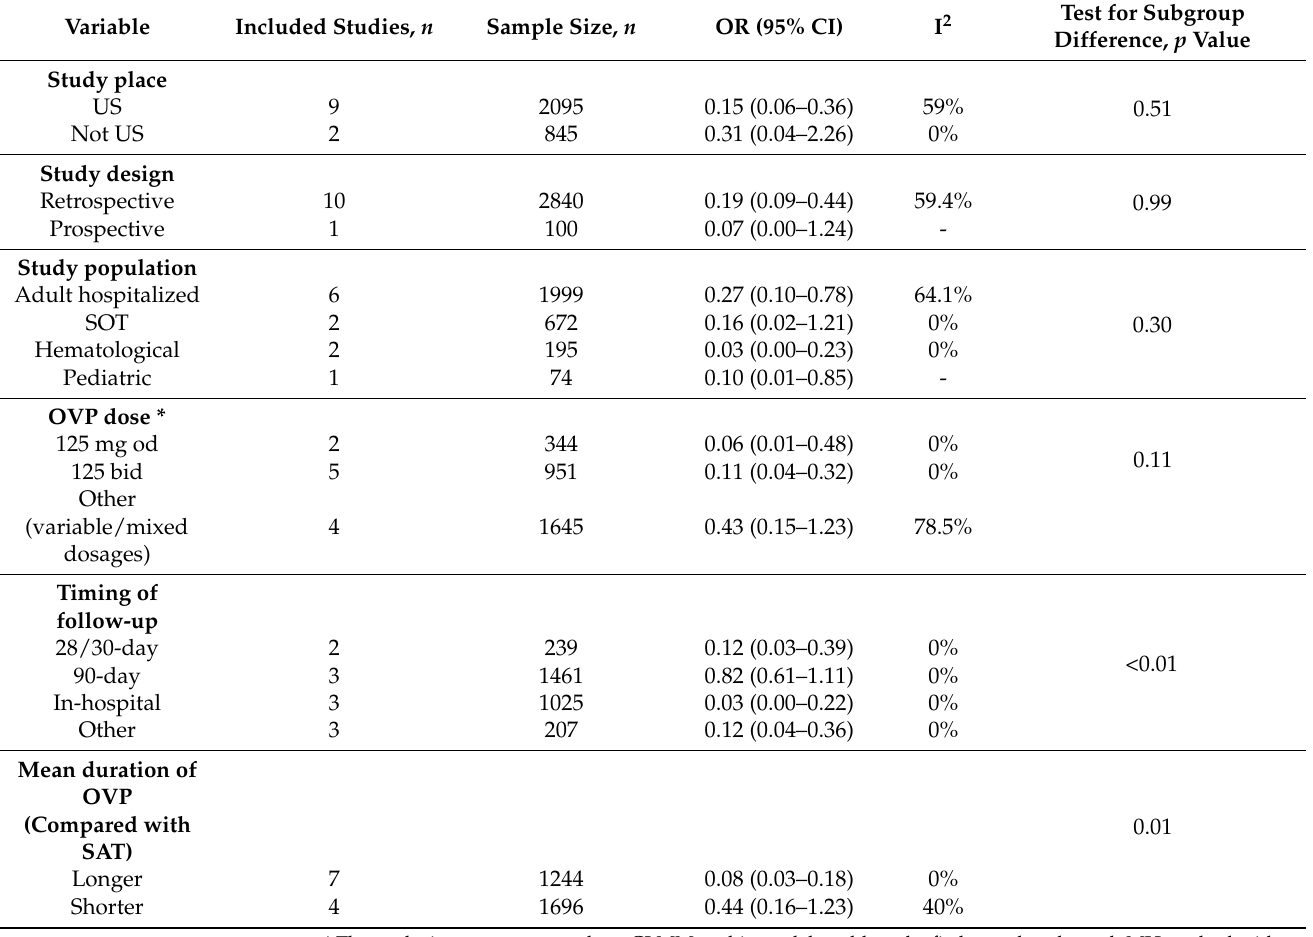
Table 2. Subgroup analysis of CDI occurrence under OVP versus no intervention in the overall